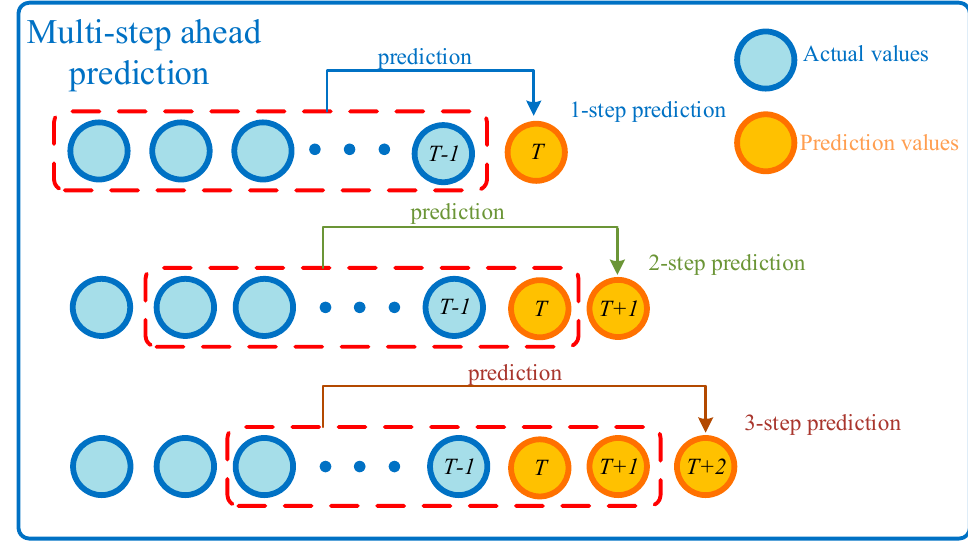
Figure 2. The framework of the proposed model.